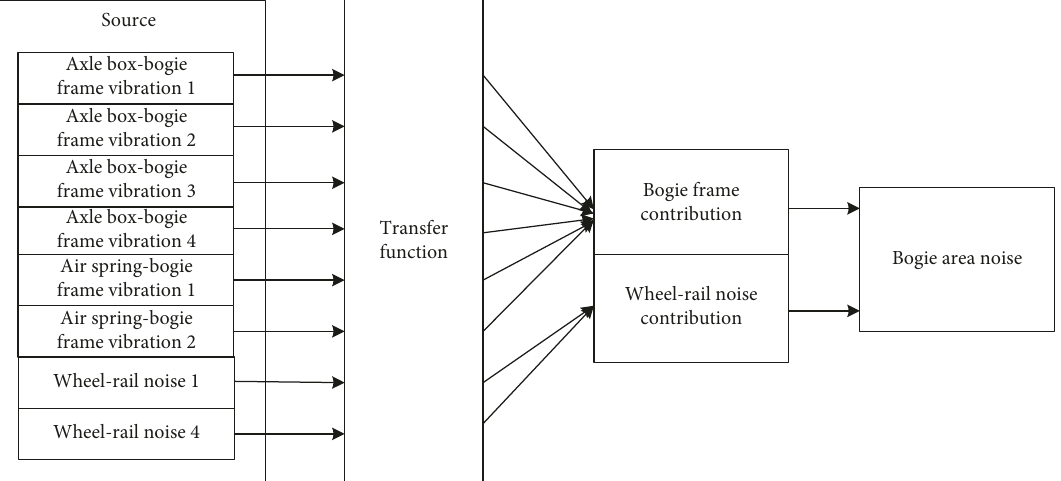
Figure 6: Bogie area transfer path TPS computing